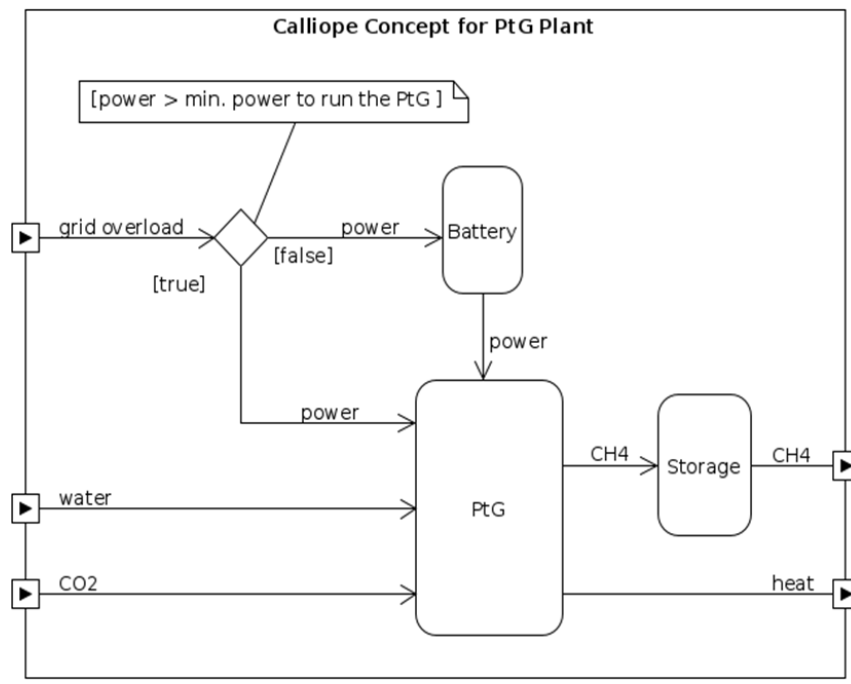
Figure 7. Abstract concept for a PtG plant implemented in